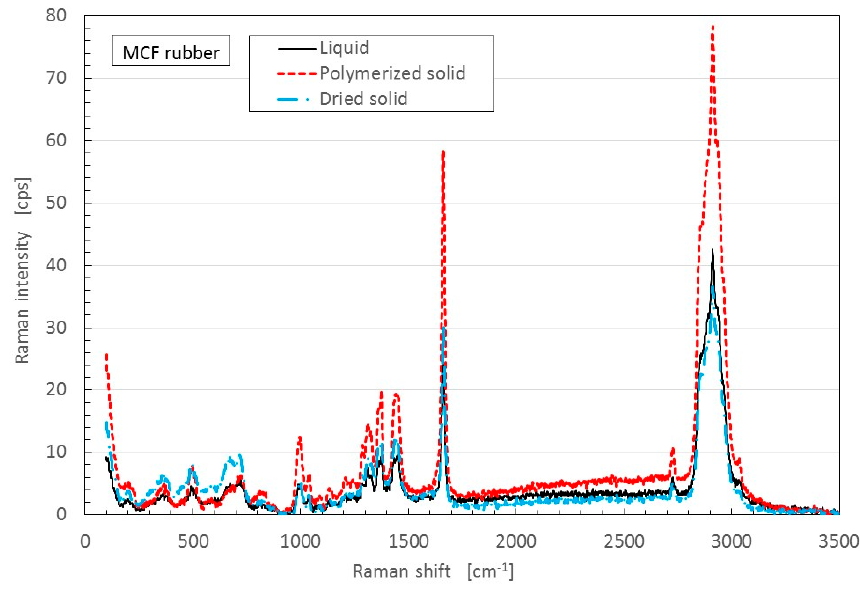
Figure 11. Raman spectroscopy spectra of the electrolytically polymerized MCF rubber of anode-side surface indicated as “Polymerized solid”: MCF rubber liquid before the application of electric and magnetic fields as “Liquid”; MCF rubber of anode-side surface solidified by the DM with a magnetic field as “Dried solid”.